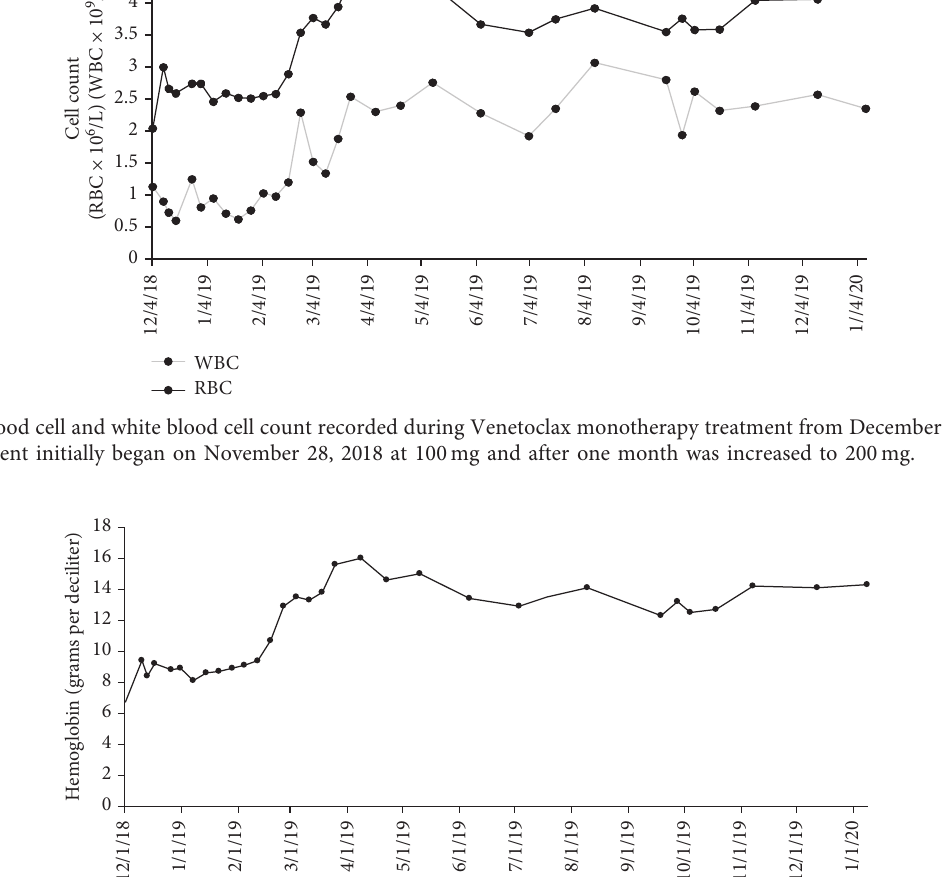
Figure 2: Hemoglobin recorded during Venetoclax monotherapy treatment from December 2018 to January 2020. The treatment initially began on November 28, 2018 at 100mg and after one month was increased to 200mg.